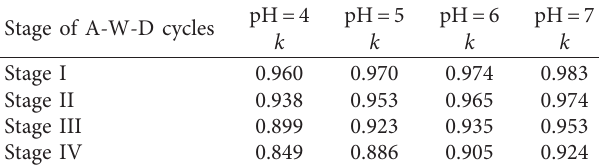
Table 4: Variation of k value of sandstone specimen under different conditions.